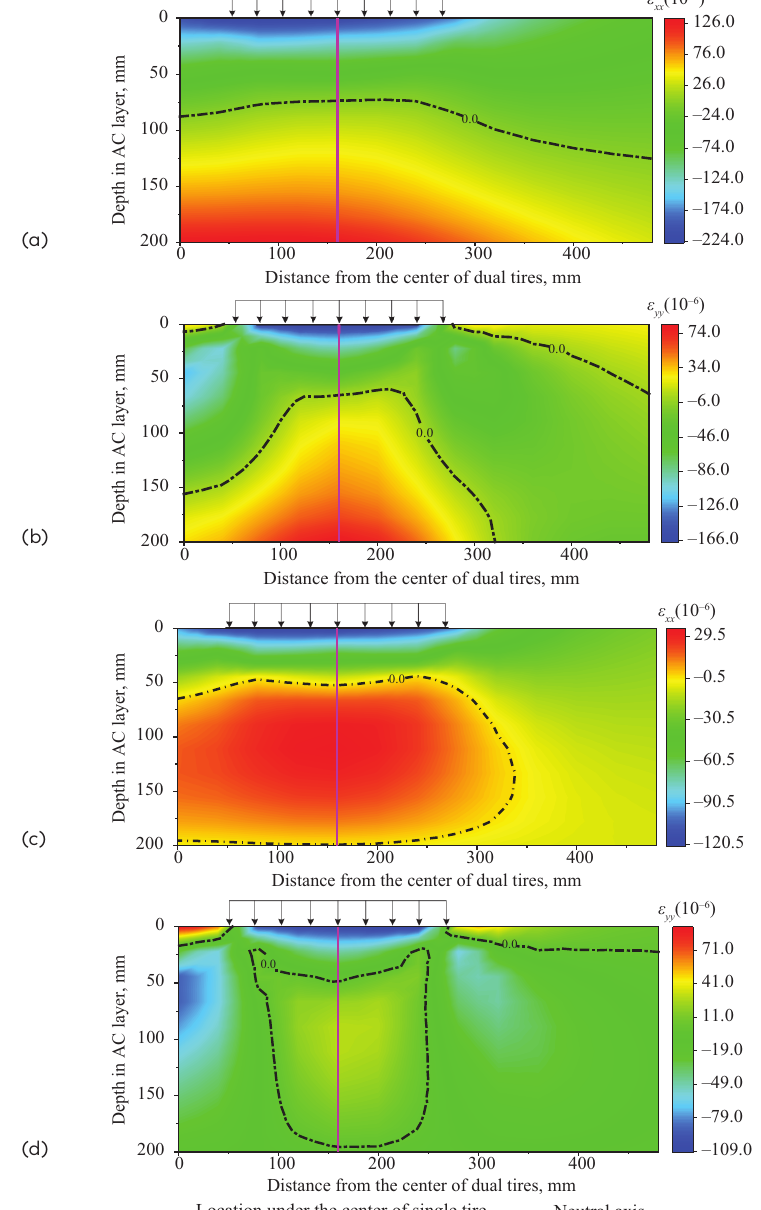
Figure 8. Contour of strains in the AC layer: (a) along the driving direction with R m = 0.25; (b) along the transverse direction with R m = 0.25; (c) along the driving direction with R m = 3; (d) along the transverse direction